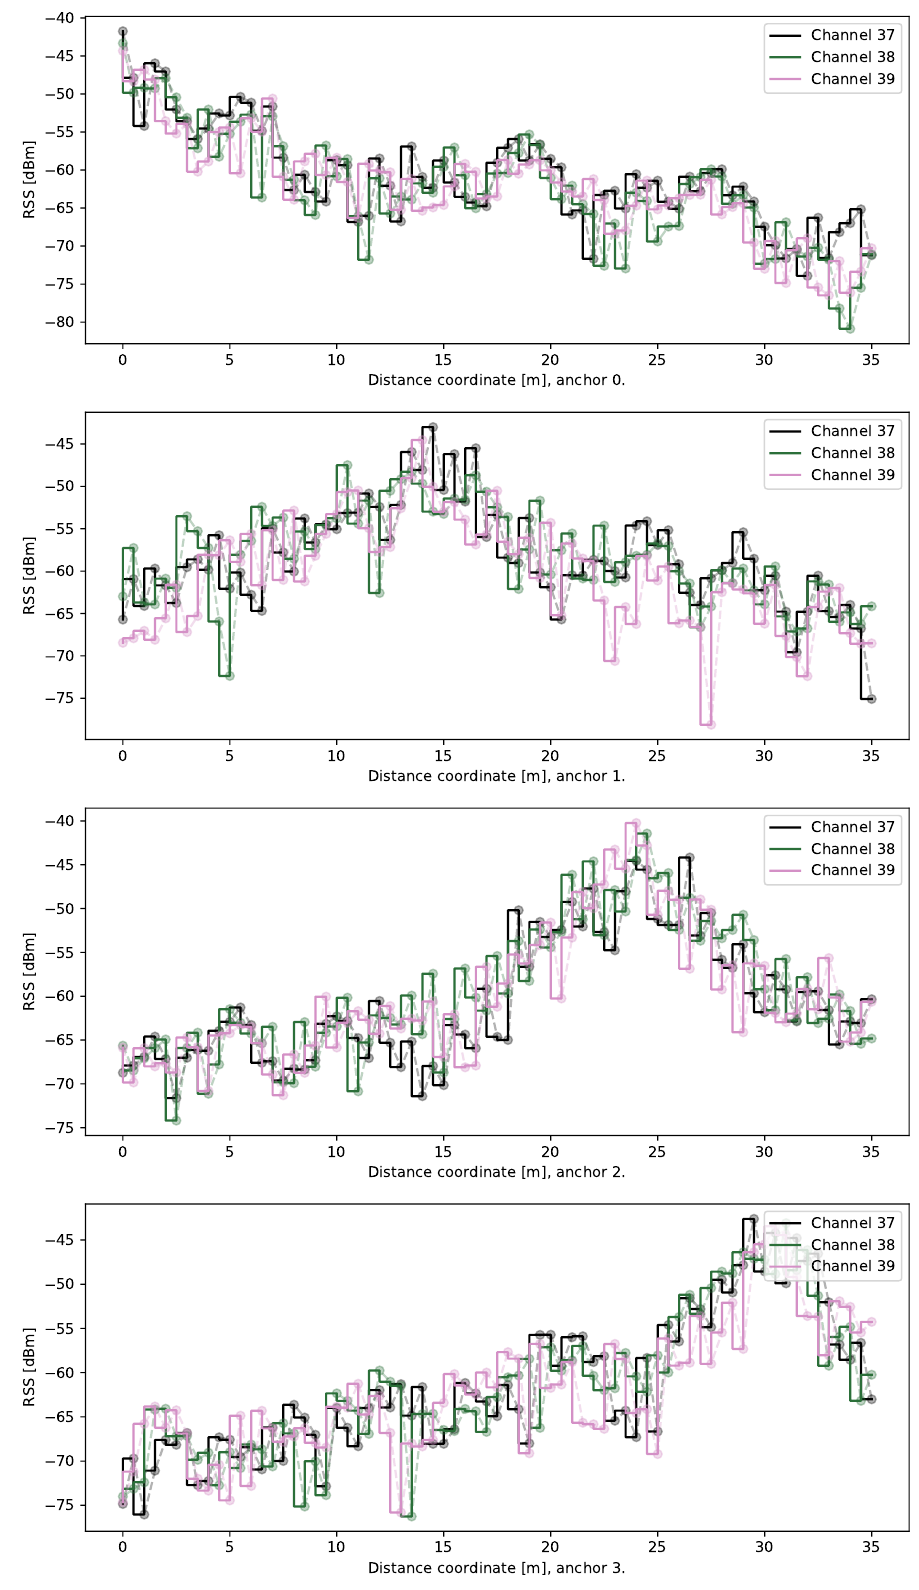
Figure 6. Mean values of received signal strengths at four anchor location when the transmitter is the moving tag. For each location, the mean of all received measurement samples is displayed. Peaks of RSS are visible for all advertisement channels for distances from 0 to